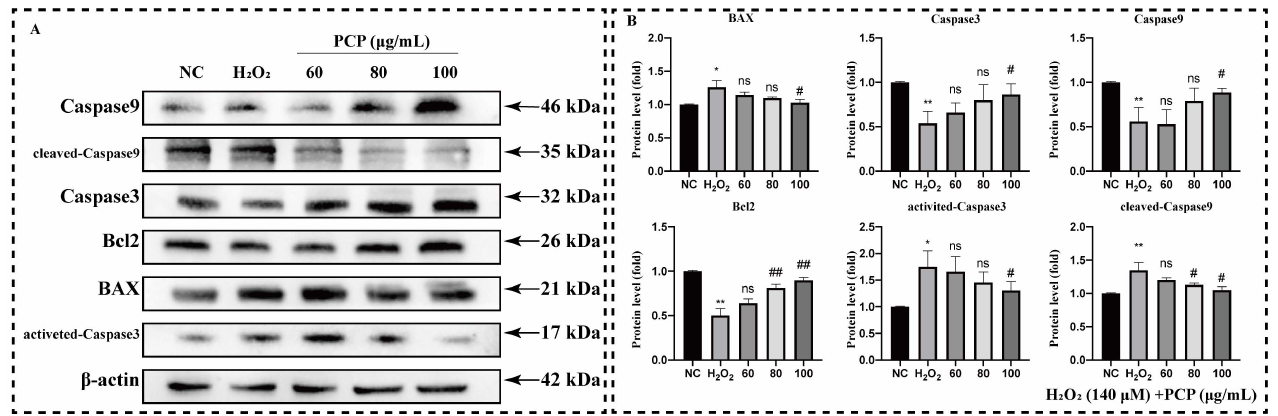
Figure 4. PCP activated BAX/Bcl2/cleaved Caspase3 pathway inside microglia. The cells were treated using H 2 O 2 (140 µ mol) and PCP at different concentrations (0, 60, 80, and 100 µ g/mL) for 24 h. The NC group treated with DMEM medium was set up as the control. Then, the levels of BAX, Bcl2, Caspase3, activated Caspase3, Caspase9, and cleaved Caspase9 proteins were evaluated by Western blotting, measuring the grey value using ImageJ. BAX, Bcl2, Caspase3, activated Caspase3, Caspase9, and cleaved Caspase9 protein ( A ) levels. Statistics of the protein’s grey value after β -actin standardization. ( B ) (standardized with β -actin). ( ns p > 0.05, * p < 0.05, ** p < 0.01, # p < 0.05, and ## p <